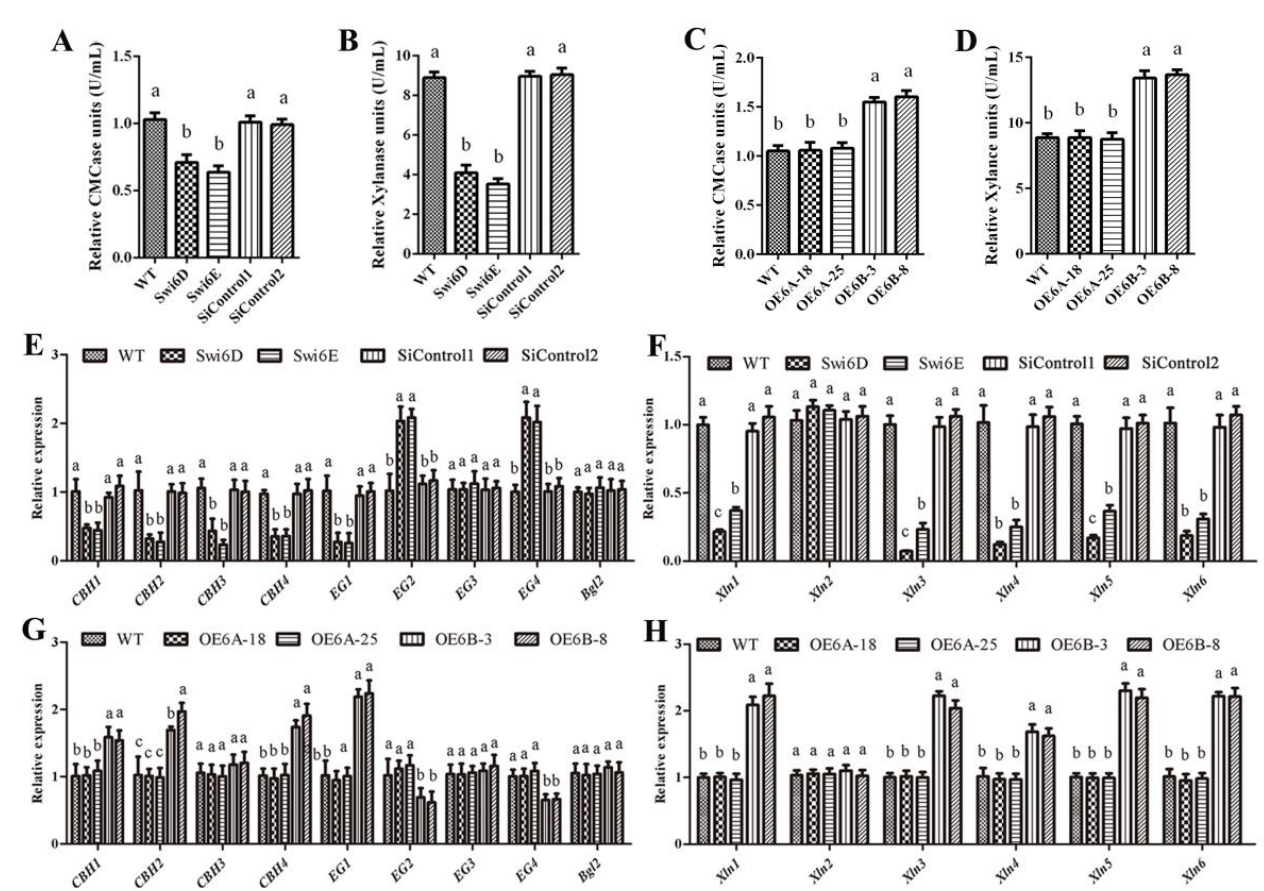
Figure 1 . Effect of GlSwi6 on cellulase and xylanase activities. ( A , C ) CMCase activities in GlSwi6-silenced ( A ) and overexpression strains ( C ). ( B , D ) Xylanase activities in GlSwi6-silenced ( B ) and overexpression strains ( D ). ( E , G ) The expression of cellulase genes in GlSwi6-silenced ( E ) and overexpression strains ( G ). ( F , H ) The expression of xylanase genes in GlSwi6-silenced ( F ) and overexpression strains ( H ). G. lucidum cultured in CYM medium for 5 days was transferred to MCM medium using cellulose as a sole carbon source for 24 h. Values are the mean ± SE ( n = 3). Different letters indicate significant differences between the strains ( p < 0.05, Tukey′s test).